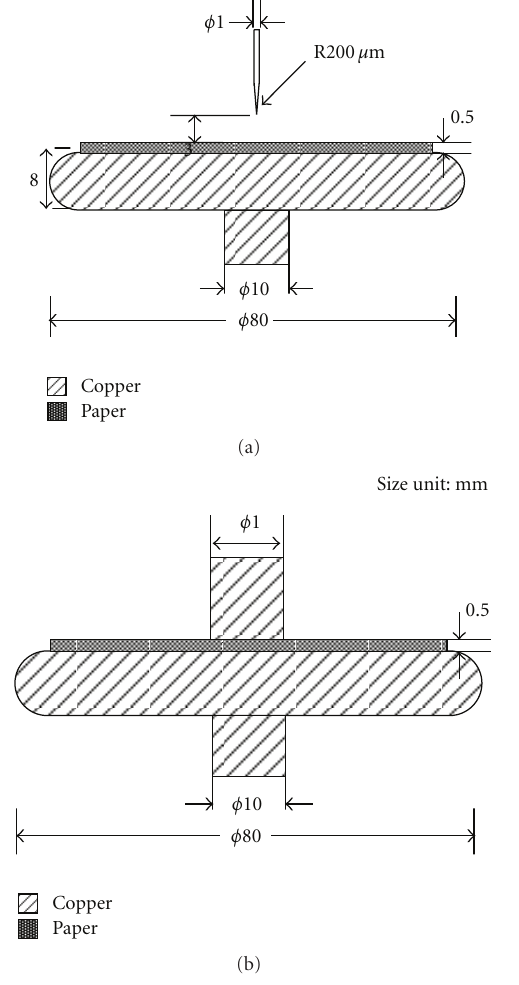
Figure 9: Two types of artificial defect models: (a) corona-in-oil model, (b) surface discharging-in-oil model.